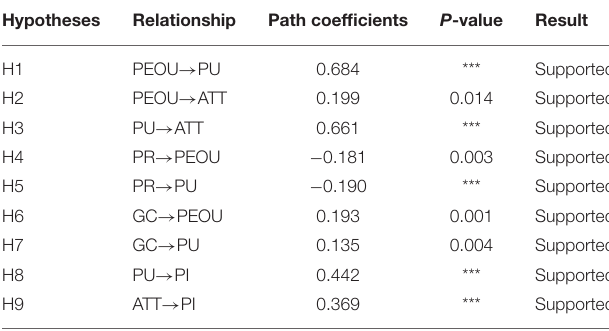
TABLE 6 | Hypotheses of the research.